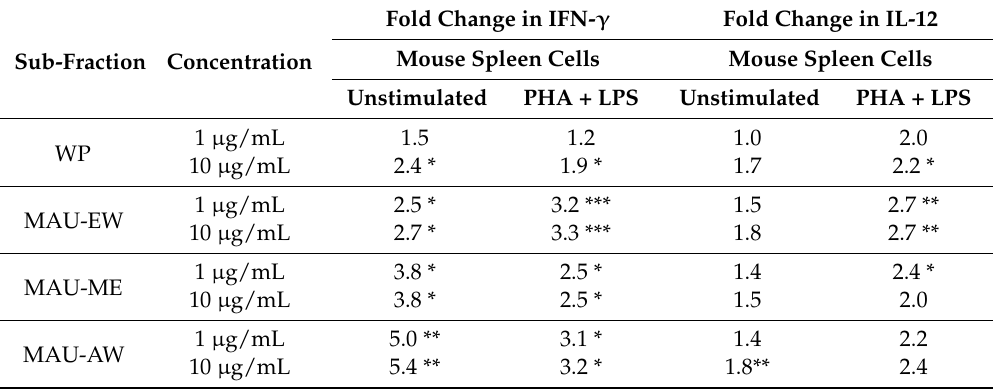
Table 2. Effect of different concentrations of sub-fractions from WP on IFN- γ and IL-12 production from stimulated and unstimulated mouse spleen cells.